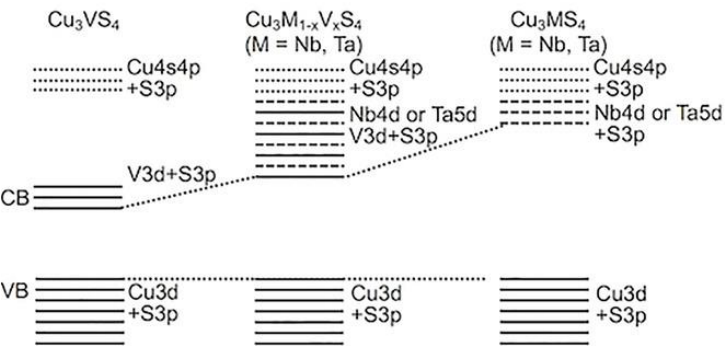
Figure 9. Proposed band structures for Cu 3 M 1−x V x S 4 (M = Nb and Ta) solid solutions. Li et al. synthesized the VS 2 @C 3 N 4 heterojunction with S vacancies via the in situ